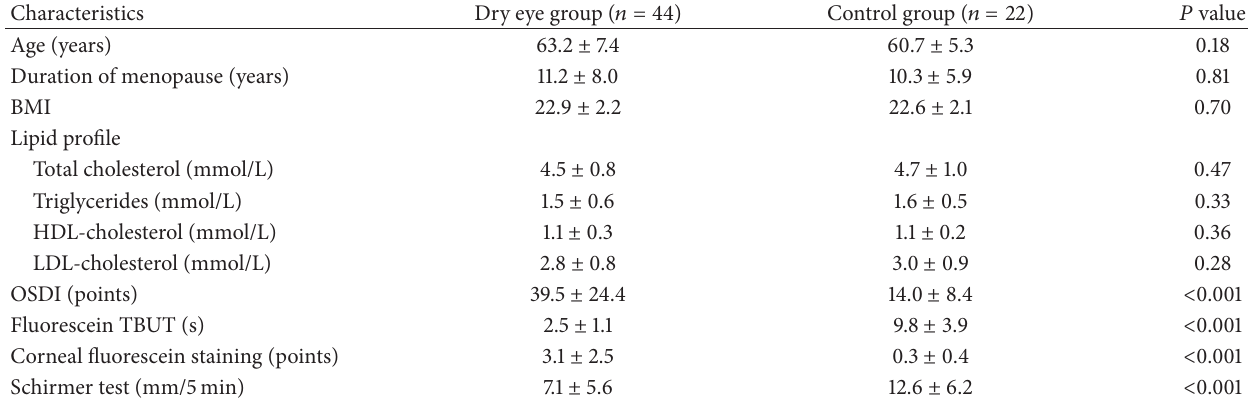
Table 1: Demographics and clinical characteristics in patients with dry eye and normal